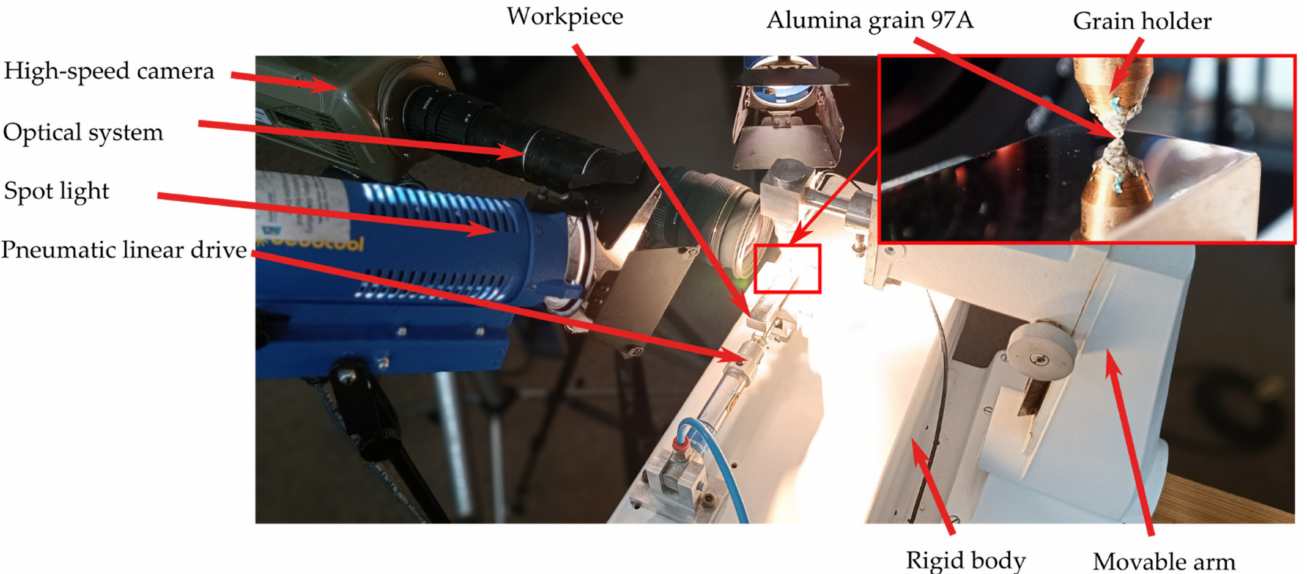
Figure 3. General view of the test stand for scratch